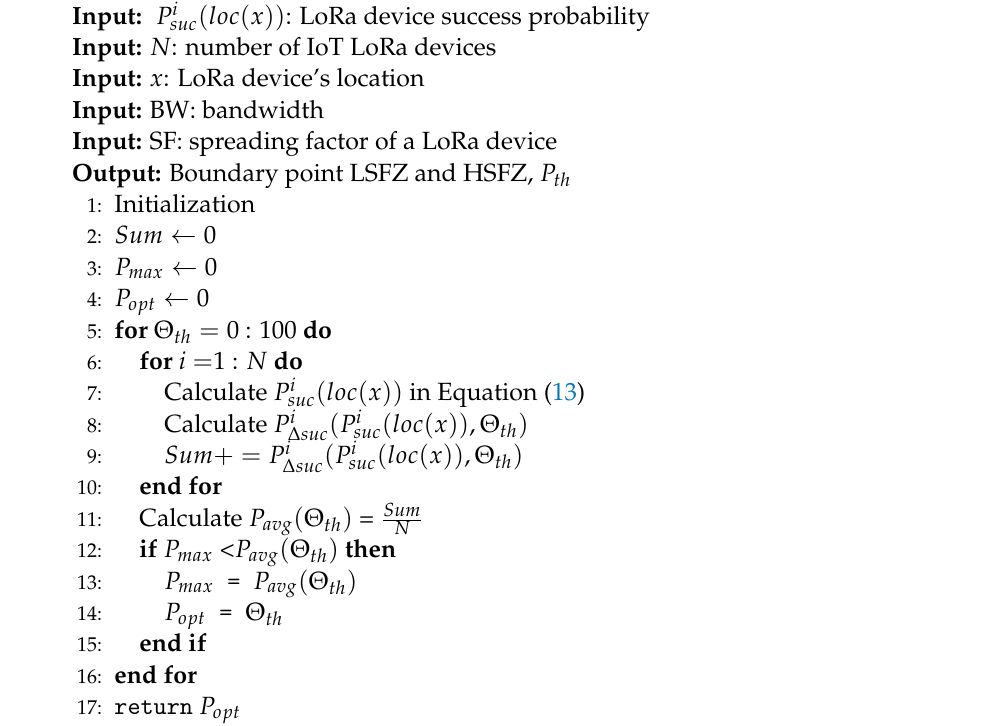
Algorithm 1: Pseudocode for boundary cut-off point of LSFZ and